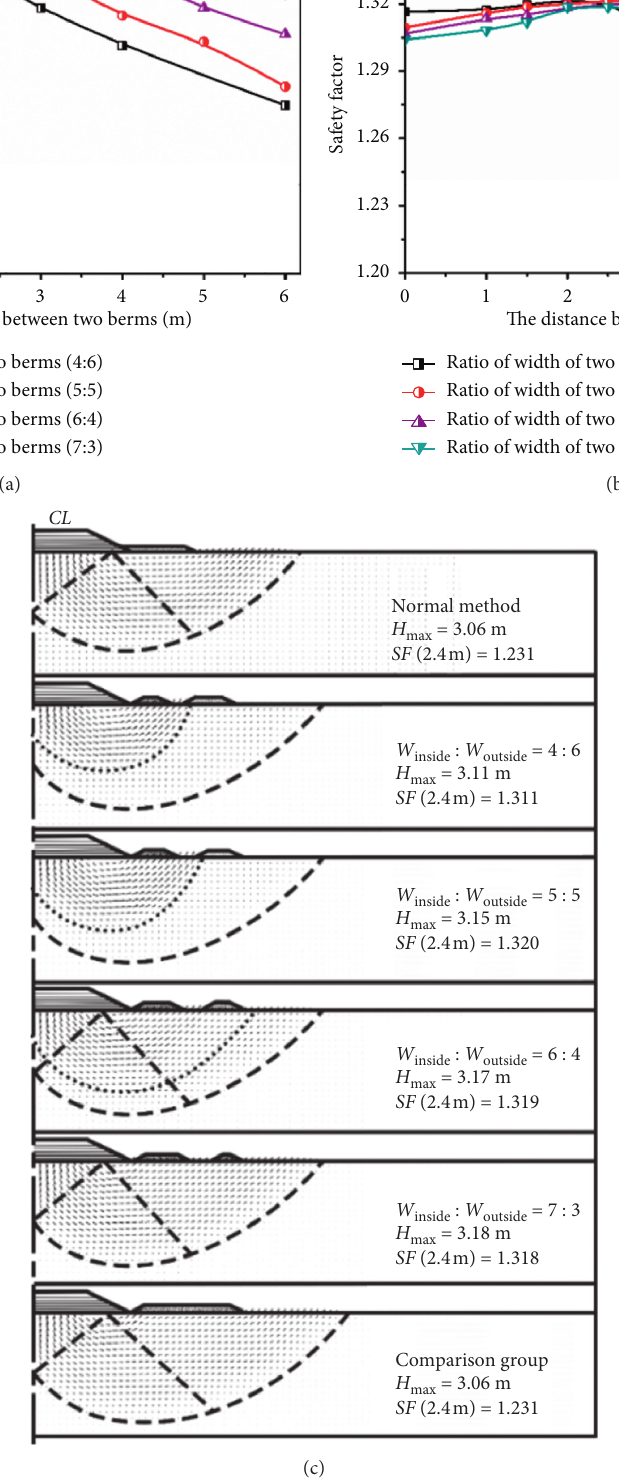
Figure 12: Effect of height of berms: (a) effect on limiting stack height; (b) effect on safety factor; (c) soil heaving mechanism of large-scale sandbag cofferdams with different berm